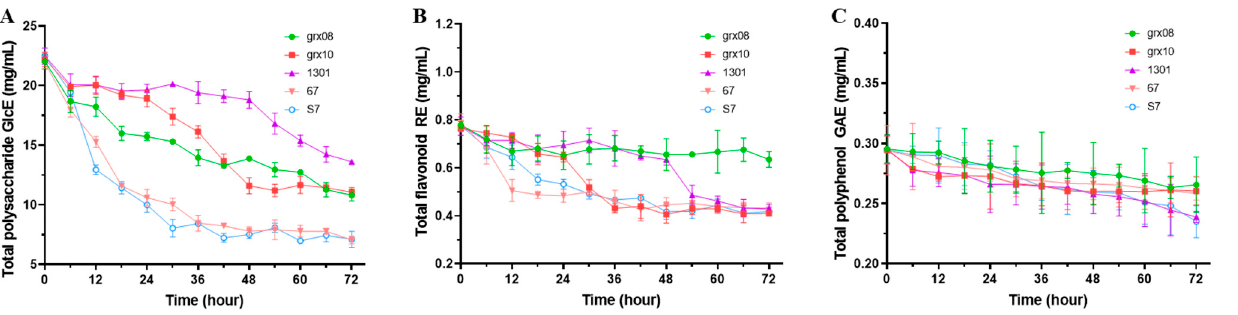
Figure 3. Changes in the contents of functional components in SHLE fermented by LAB. ( A ) Total polysaccharide, ( B ) total flavonoid and ( C ) total polyphenol. Values are expressed as the mean ± standard deviation of replicate experiments ( n = 3).